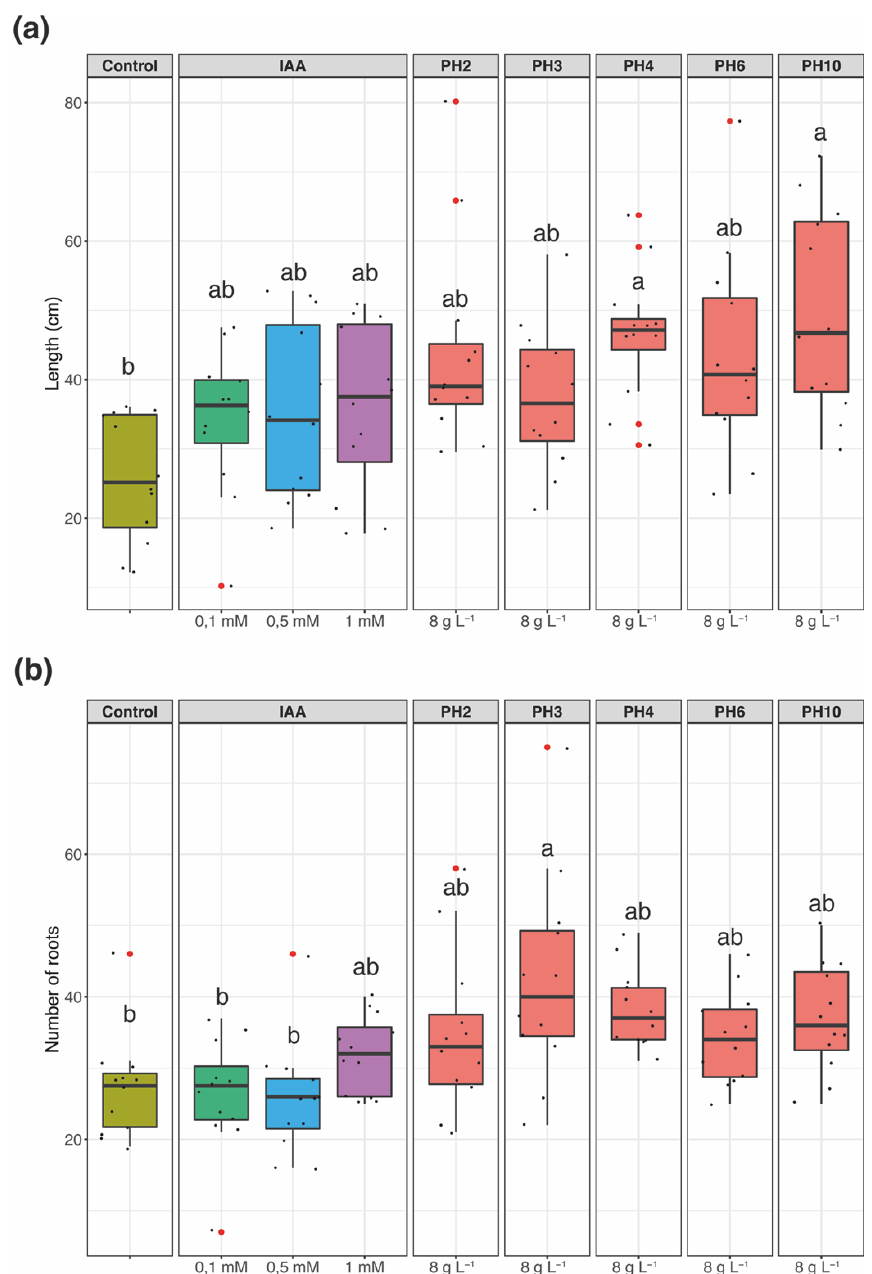
Figure 1 . Root growth parameters of tomato plants as affected by different treatments. ( a ) Total root length and ( b ) total number of roots determined in tomato cuttings at 7 days after treatments. The analyses were carried out on at least 10 cuttings per each treatment. Different letters indicate significant differences according to one-way ANOVA with Tukey post hoc tests ( p < 0.05).